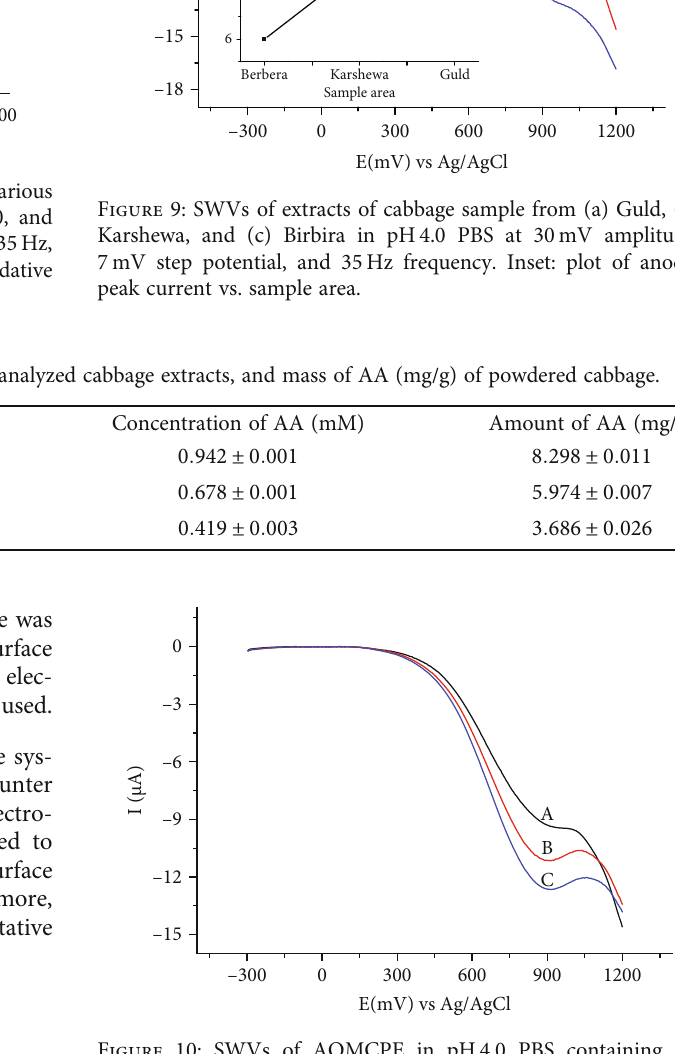
Figure 10: SWVs of AQMCPE in pH 4.0 PBS containing (a) Karishewa cabbage extract solution, (b) a +5ml of 2.0mM standard AA, and (c) b +5ml of 2.0mM